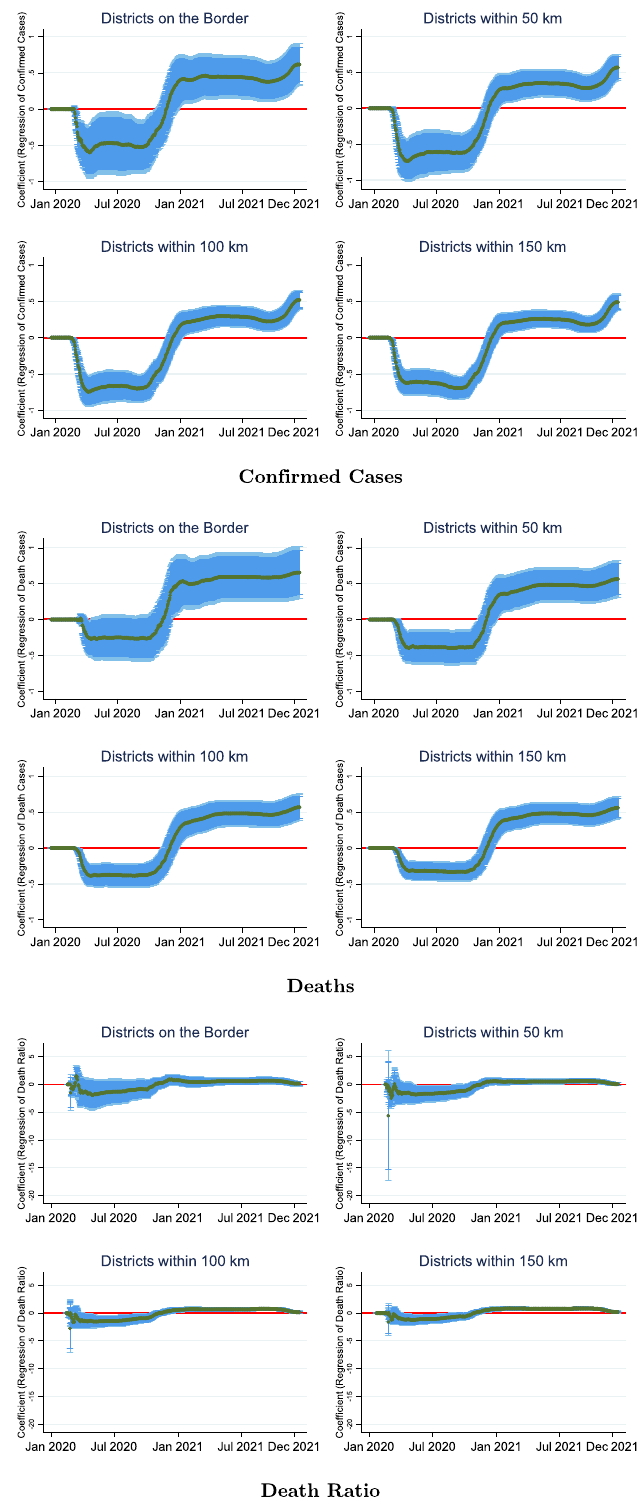
Fig. 5 Regression coef fi cients of COVID-19 variables on East for German districts near the border. Daily regression coef fi cients (95 and 90% con fi dence interval) of con fi rmed cases, deaths and death ratio on East for German districts on the border and within 50/100/150 km of the border, 2020 and